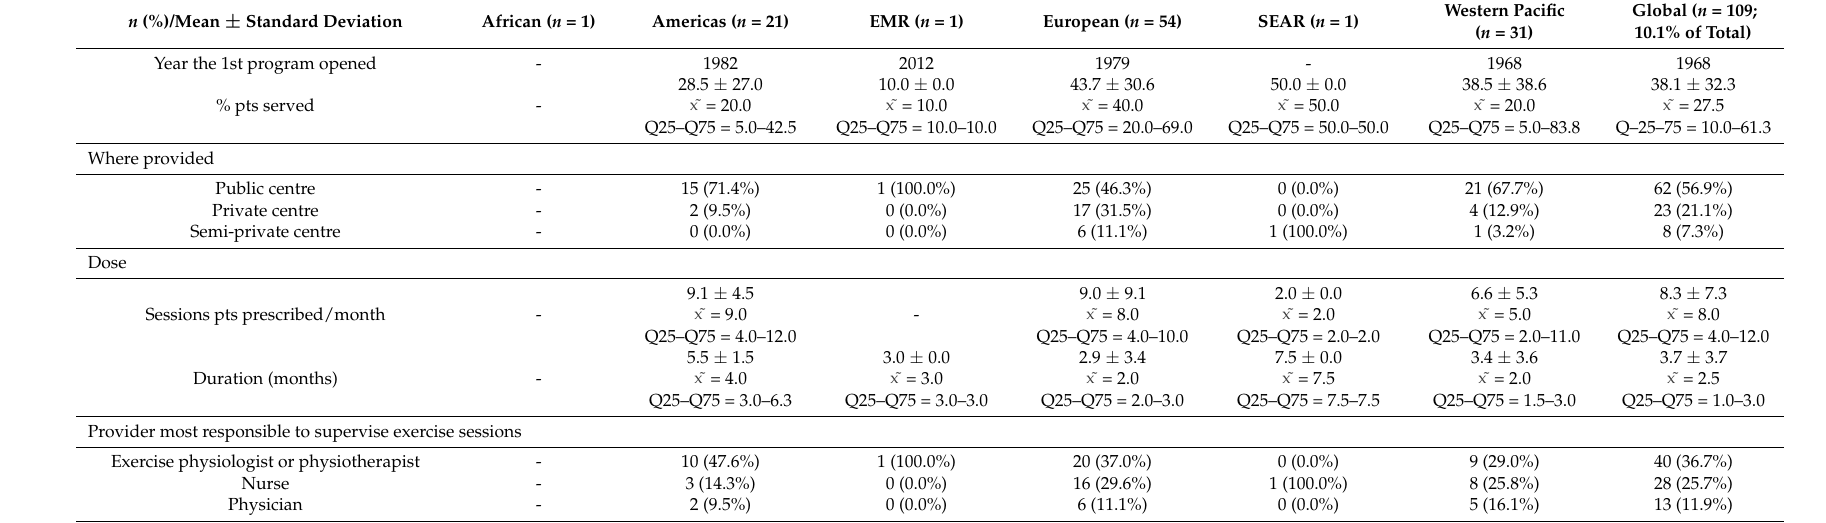
Table 2. Characteristics of Community-Based Programs by World Health Organization Region. Table 1. Characteristics of Home-Based Programs by World Health Organization Region. Table 1. Characteristics of Home-Based Programs by World Health Organization Region. Table 1. Characteristics of Home-Based Programs by World Health Organization Region. Table 1. Characteristics of Home-Based Programs by World Health Organization Region. Table 1. Characteristics of Home-Based Programs by World Health Organization Region. Table 1. Characteristics of Home-Based Programs by World Health Organization Region. Table 1. Characteristics of Home-Based Programs by World Health Organization Region. Table 1. Characteristics of Home-Based Programs by World Health Organization Region. Table 1. Characteristics of Home-Based Programs by World Health Organization Region. Table 1. Characteristics of Home-Based Programs by World Health Organization Region. Table 1. Characteristics of Home-Based Programs by World Health Organization